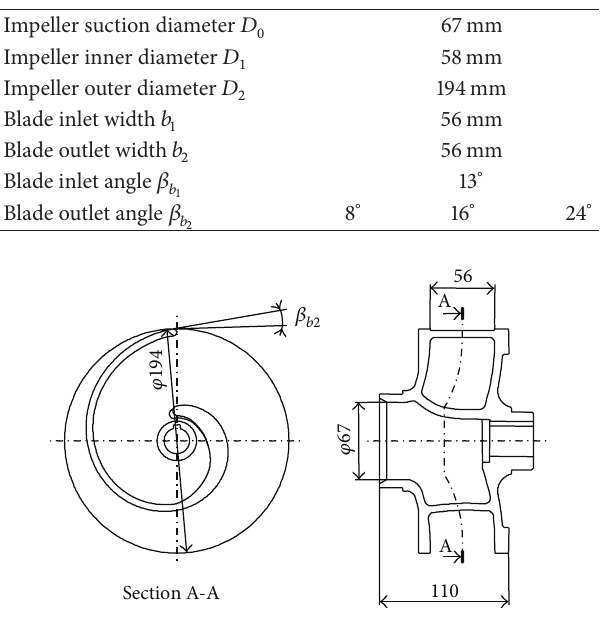
Table 1: Specifications of test impellers.